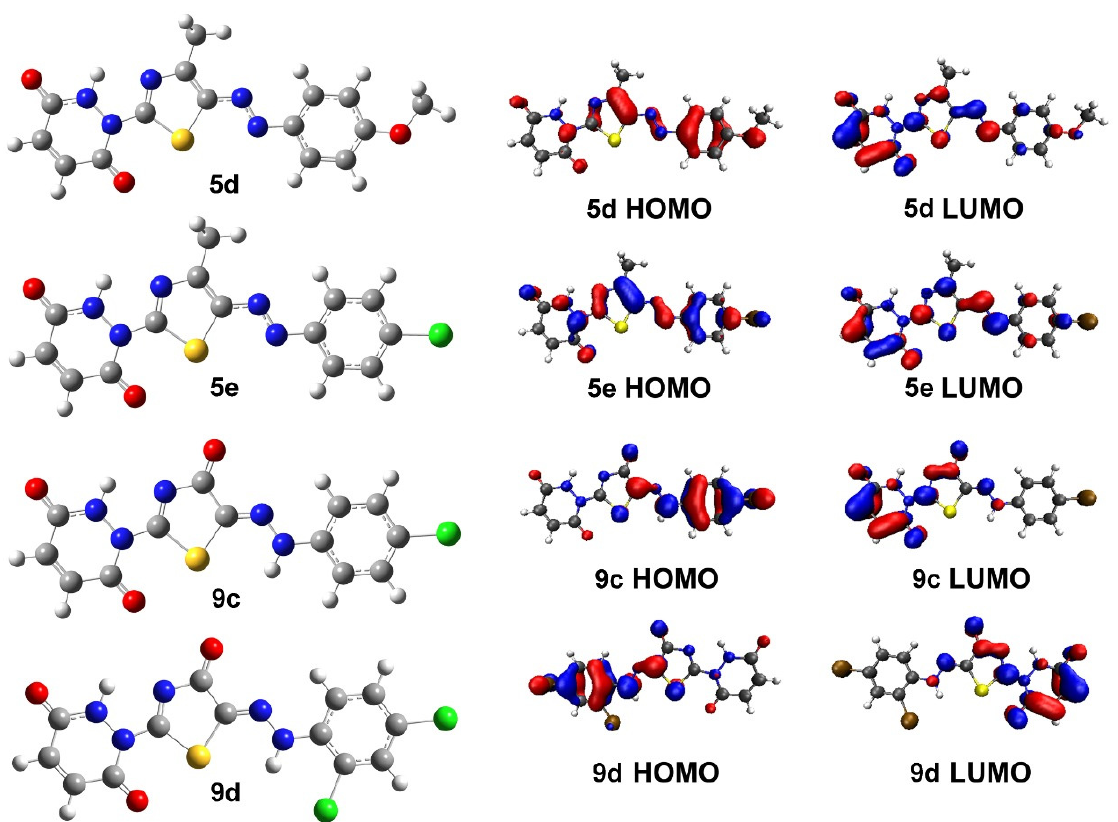
Figure 1. Optimized molecular geometries and molecular orbitals of candidate molecules with the highest antimicrobial properties. Table 2. Quantum chemical parameters of compounds 6d, 6e, 10c and 10d